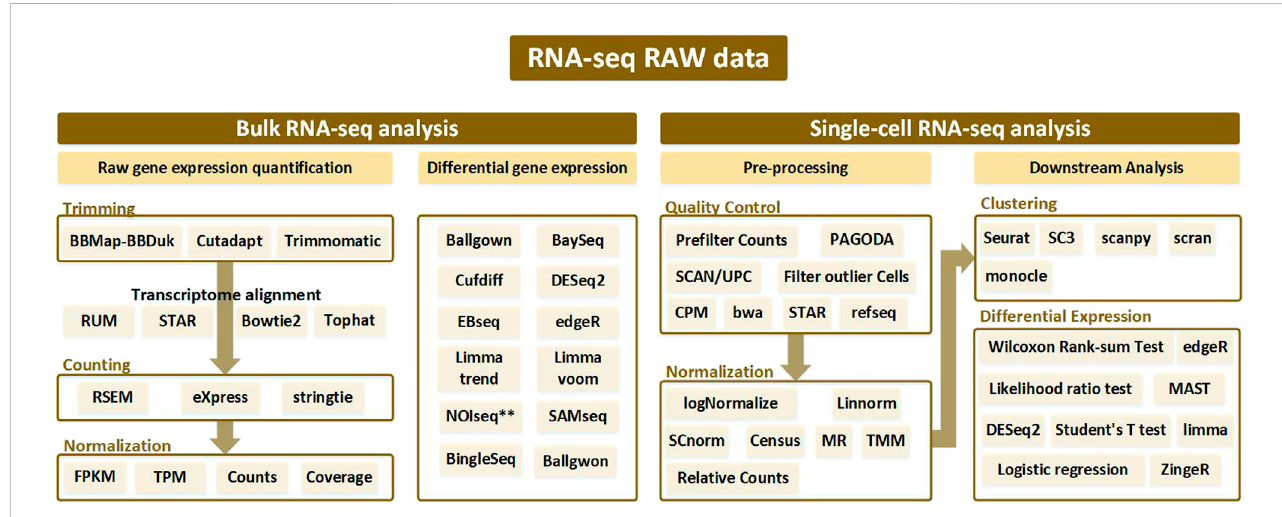
FIGURE 1 Analysis pipeline according to bulk RNA-seq and single-cell RNA-seq from RNA-seq raw data. Bulk RNA-seq analysis is divided into two pipelines: raw gene expressionquanti fi cation (which leads to trimming, counting, and normalization) and differential gene expressionanalysis. Alignment is performed after trimmingtoremovecontaminationfromthesequenceddata,andvarioustoolsusedatthistimearegenerallybowtie-based.Afterwards,thecountingprocess is performed to remove the biased sequencing data, and after normalization, the processed data goes through the fi nal step of discriminating the expressedgene through differential gene expression analysis. In single-cell RNA-seq analysis, processes such as trimming and mapping are batch-processed in the quality control stage, and normalization is performed. After that, a clustering procedure to differentiate between similar cell types is essential. Then the single-cell RNA-seq analysis work fl ow is completed with differential expression